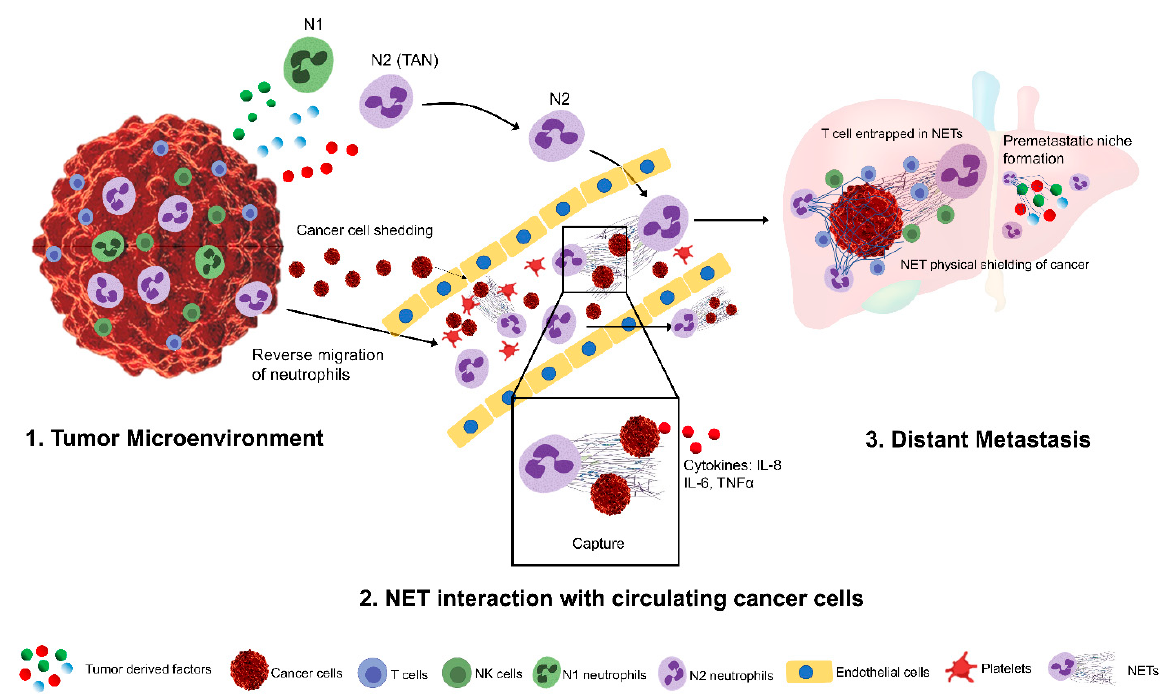
Figure 1. A simplified schematic representation of tumor-associated neutrophils (TANs) in promoting tumor metastasis. In